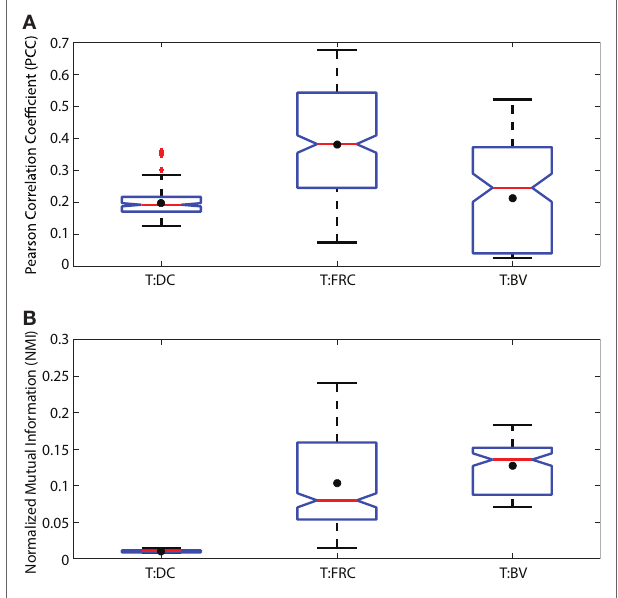
FigUre 2 | Illustration of low, medium and high MI. Simulated images of 500 red and 500 green cells are shown in panels (a–c) . Each cell is a square of 11 × 11 pixels. The location and color intensity of each green cell is chosen from a uniform random distribution. A red cell is paired with each green cell. The red cell has the same color intensity as the green cell, but with a different spatial association in each case. In panel (a) , red cells are placed at random locations uncorrelated with green cell placements. In panel (B) , the placements of red and green cells are partially correlated. Red cell locations are chosen from a Gaussian distribution centered at the location of the paired green cell, but with a standard deviation ( σ = 5). In panel (c) , the location of red and green cells is identical ( σ = 0). (D–F) Set diagrams indicating the shared information between red and green channels. In panel (D) , the two color channels are independent since cell locations are uncorrelated with each other providing minimum MI. In panel (e) , the two images are partially correlated which increases the MI, shown by the yellow shaded region. In panel (F) , the two images are completely correlated maximizing the MI of the two color channels, resulting in complete intersection of the information in the red and green channels (yellow region). Panels (g–i) joint probability tables for images (a–c) where 256 color intensities are binned into 4 color intensities for purposes of illustration, resulting in a 4 × 4 probability table. In panel (g) , the probability values are low and evenly spread across the table, except for the upper left corner, indicating overlap in the space with no cells (MI = 0.0011 bits). In panel (h) , the probability values are higher along the diagonal than in other parts, indicating partial correlation in the placement of red and green cells (MI = 0.0320 bits). In panel (i) , there are probability values on the diagonal only and the probabilities off the diagonal are 0 since there is complete correlation in the placement of red and green cells (MI = 0.8610 bits). The calculation of entropy H( r ) and H( g ), joint entropy H( r , g ), and MI are shown for each case.